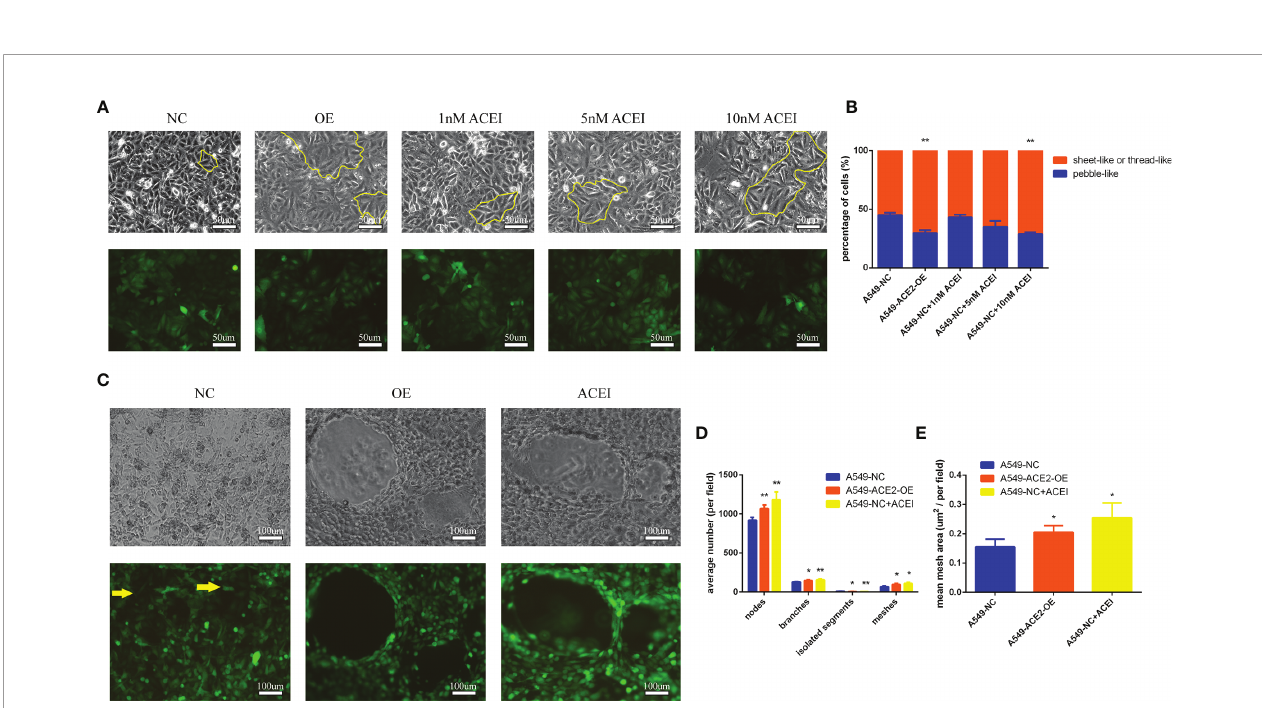
FIGURE 4 | Tube formation ability of A549 cells was improved with ACE inhibitory state. (A) Morphologies of a panel of A549-ACE2-OE cells, A549-NC cells, and A549-NC cells treated with ACEI (1, 5, and 10 nM/L) were shown as sheet-like and thread-like cell types in 2D culture, which were outlined partly with yellow lines. Representative images were shown above. Upper: white light; lower: fl uorescence. (B) Quanti fi cation of sheet-like or thread-like cells and pebble-like cells in three groups, representatively, Mean ± SD, n = 3, **p < 0.01. (C) Images of both above cell lines grown in 3D Matrix gel. A 10 nM/L ACEI dilution was performed. Representative images were shown above. Yellow arrows point out the free cancer cells escaping from tube wall and isolated segments. Upper: white light; lower: fl uorescence. (D, E) Images of 3D culture were applied to determine average number of nodes, branches, isolated segments, meshes and mean mesh area in those groups, per fi eld, Mean ± SD, n = 3, **p < 0.01, *p < 0.05. ns, no signi fi